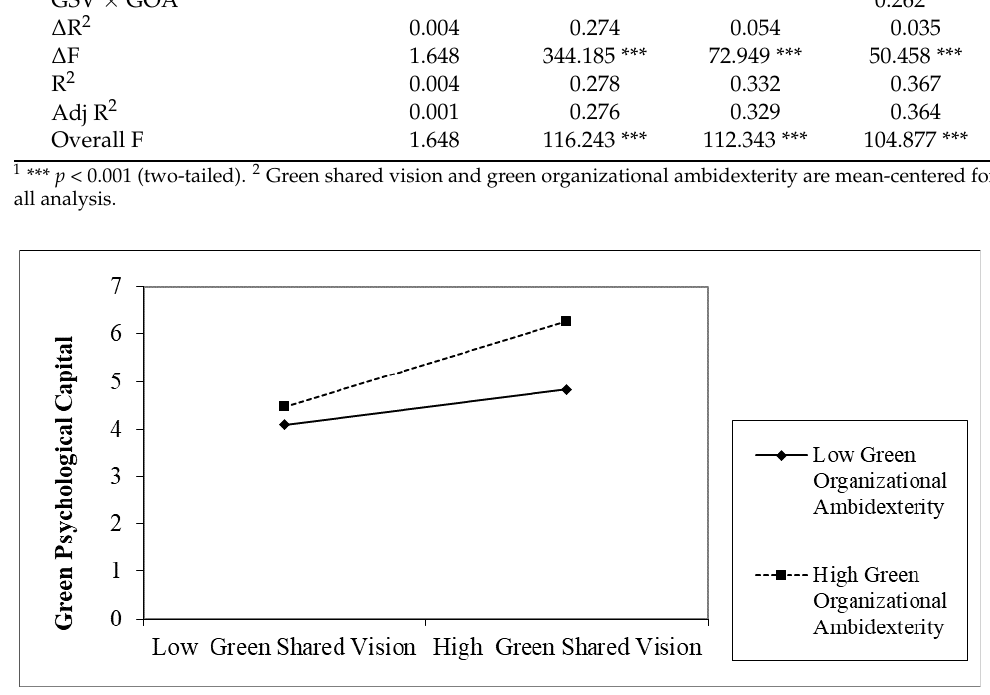
Figure 3. Moderating role of environmental attitude.